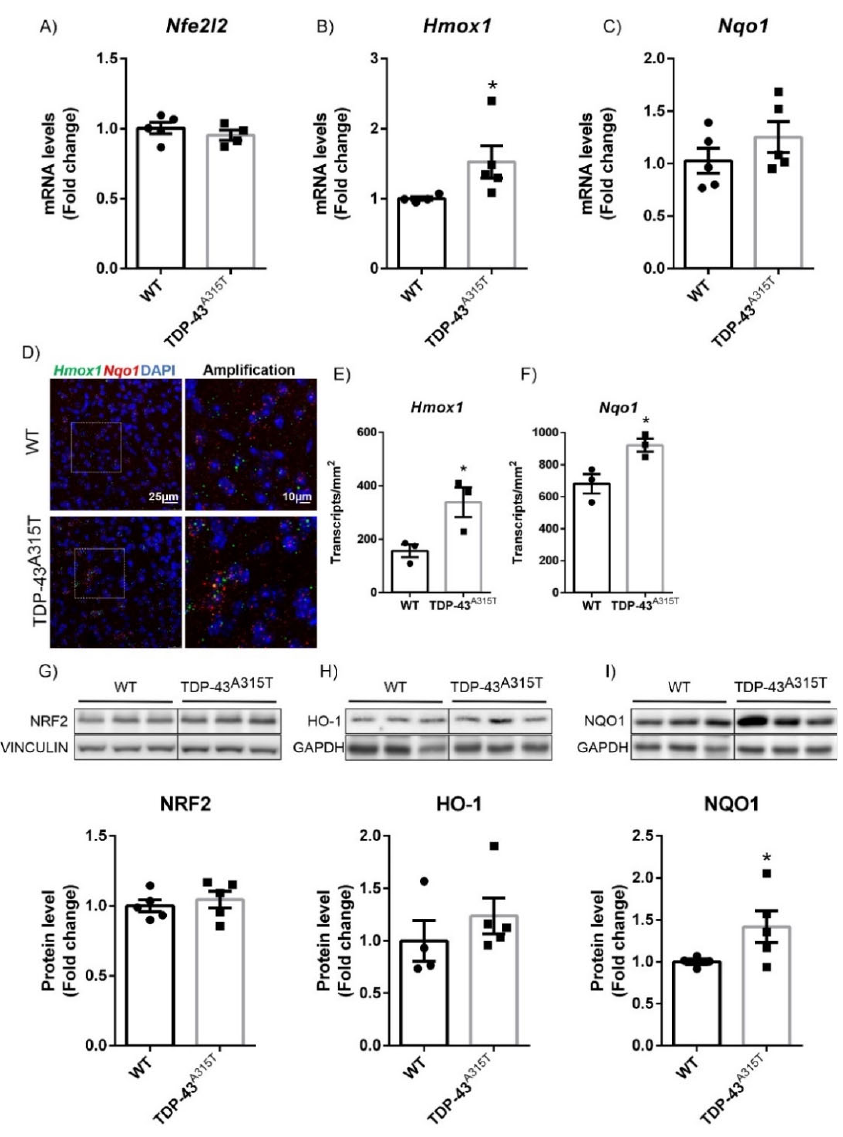
Figure 2. TDP-43 A315T transgenic mice showed increased HO-1 and NQO1 expression in motor cortex. Quantitative real-time PCR determination of mRNA levels of ( A ) Nfe2l2 , ( B ) Hmox1 , and ( C ) Nqo1 . All genes were normalized by Tbp (TATA box binding protein) mRNA levels; n = 4–5 samples ± SEM. Asterisks denote significant differences at * p < 0.05 when comparing the indicated group to the wild- type mice according to the Student’s t -test. ( D ) RNAscope ISH labelling of Hmox1 (green) and Nqo1 (red) in prefrontal cortex of 90-day-old TDP-43 A315T transgenic mice. Quantification of ( E ) Hmox1 and ( F ) Nqo1 expression using Fiji analysis. Asterisks show significant differences at * p < 0.05 when comparing groups according to the Student’s t -test. Protein levels of ( G ) NRF2, ( H ) HO-1, and ( I ) NQO1 were analyzed by immunoblotting and their respective protein quantifications; n = 4–5 samples per experimental group ± SEM. Asterisks show significant differences at * p < 0.05 when comparing groups according to the Student’s t